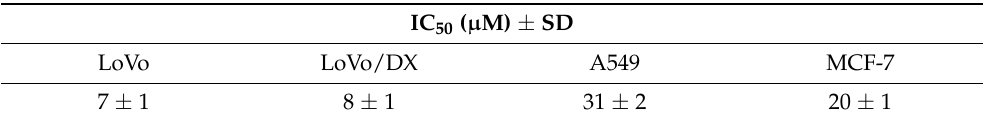
Figure 36. Synthesis of diaryl (1-isothiocyanoalkyl)phosphonates 237 – 246 . The in vitro antiproliferative activities of synthesized ITCs 237 – 246 against LoVo, LoVo/DX, A549, and MCF-7 cell lines were in the range of natural isothiocyanates despite the significant differences in their structures. Among them, ITC 246 was the most active (Table 8). Table 8. The antiproliferative activity of compound 246 .